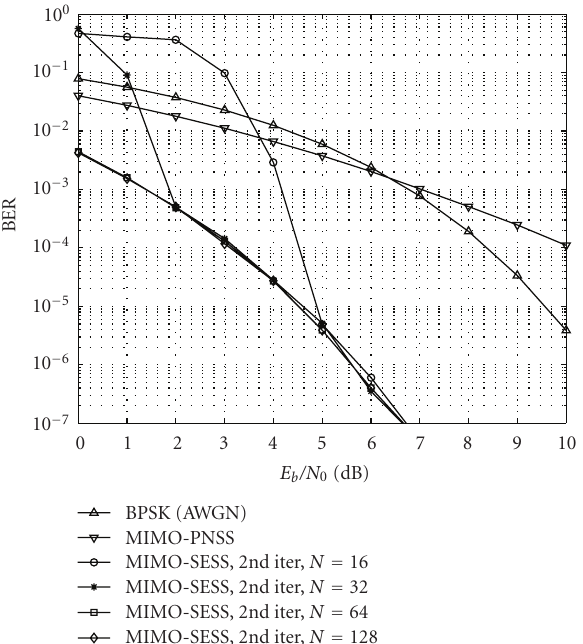
Figure 8: Performance of the proposed 2 × 2 MIMO-SESS system with iterative detection, N = 16, 32, 64,